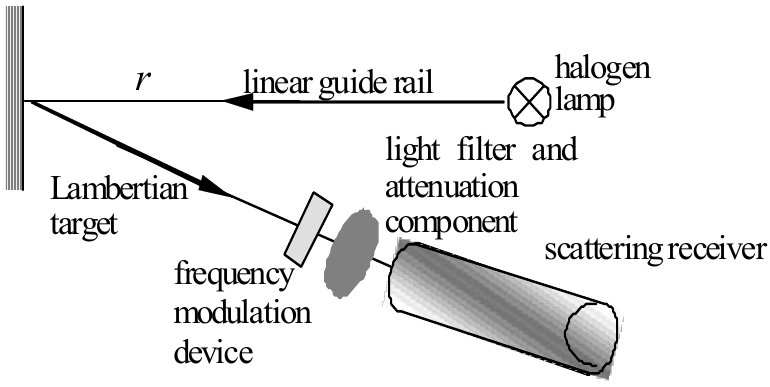
Figure 8. Volume scattering calibration